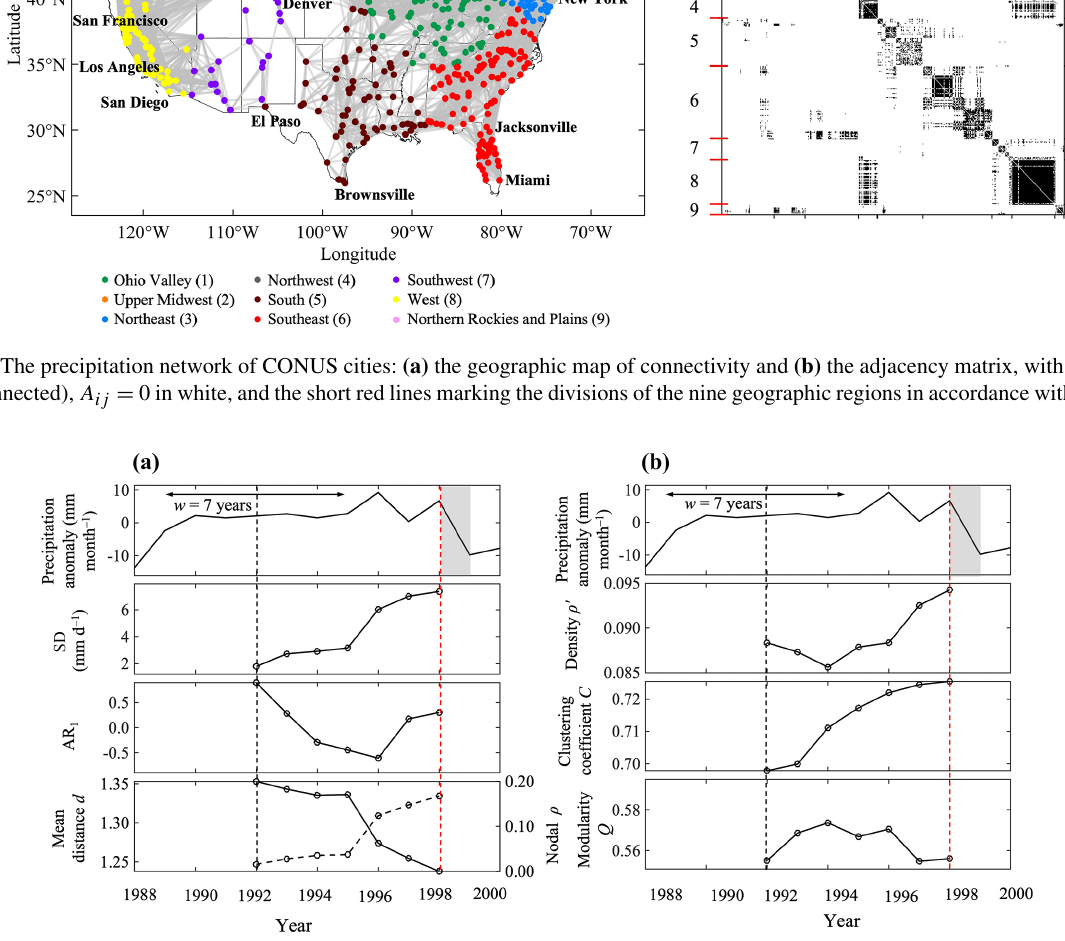
Figure 5. Early-warning signals and structural responses to the critical transitions (in the year 1998) in time-varying CONUS precipitation, as the time evolutions of (a) precipitation anomalies, AR 1 , SD, and the mean distance ( d ) and similarity ( ρ ) functions for network construction, and (b) network topological parameters of clustering coefficient ( C ), density ( ρ (cid:48) ), and modularity ( Q ). The horizontal lines with arrows show the width of one moving window (7 years), the vertical dashed red lines represent critical transitions, and the gray bands represent the transition